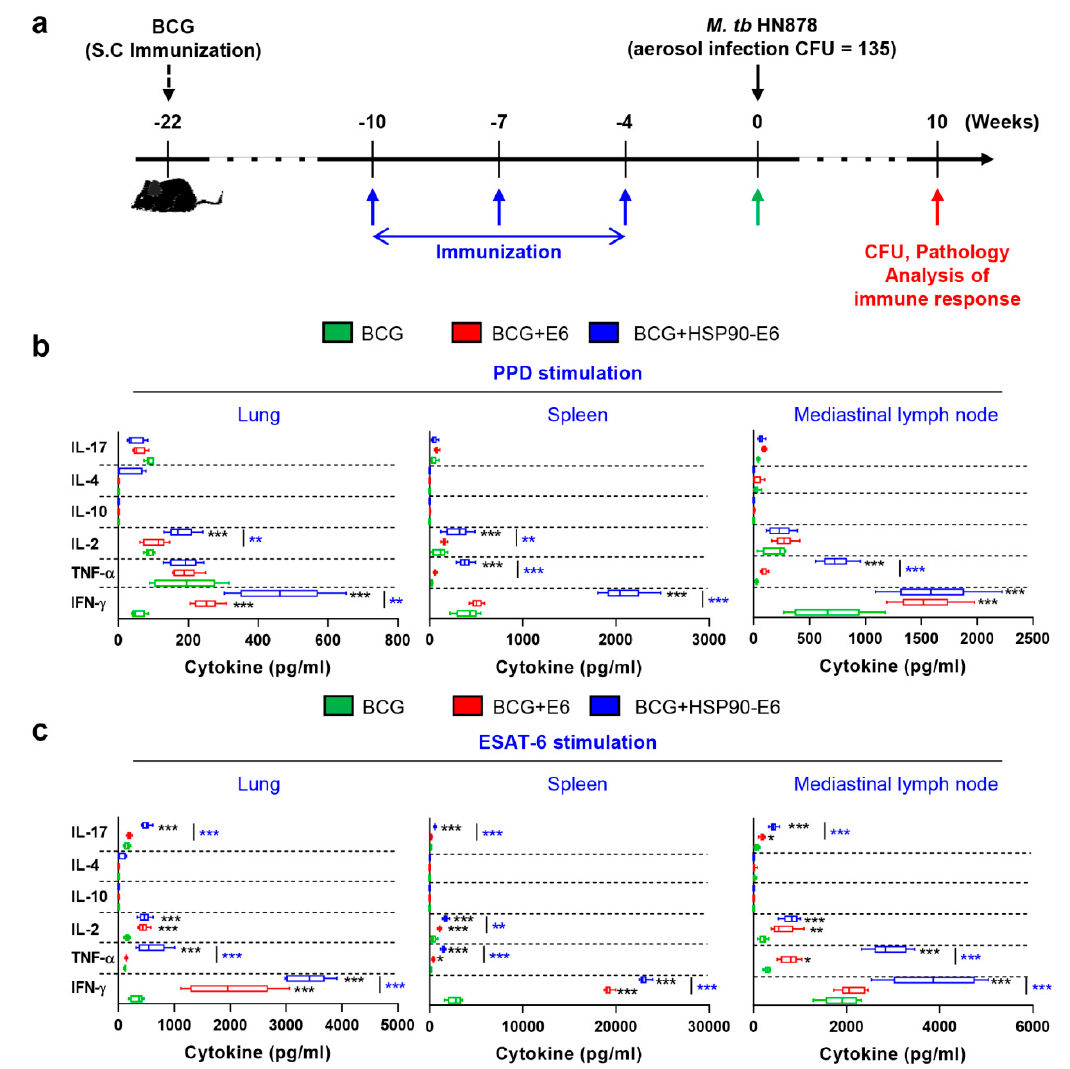
Figure 1. Comparative cytokine production profiles in Bacillus Calmette-Gu é rin (BCG)-, BCG + ESAT-6-, or BCG + HSP90-E6-vaccinated mice upon antigen (Ag) stimulation four weeks after final vaccination. ( a ) Experimental design for HSP90-E6 subunit vaccine testing. Mice (n = 12 per group) were immunised by BCG injection 12 weeks before subunit vaccination. Three intramuscular injection of HSP90-E6 / CIA05 were administered (blue arrows) before Mycobacterium tuberculosis (Mtb) HN878 aerosol challenge (black arrow). Immunological analysis was conducted before (green arrow) and after Mtb infection (red arrow). Bacterial counts and histopathology in each group were determined at the indicated time points after Mtb infection (red arrow). ( b , c ) Levels of IFN- γ , TNF- α , IL-2, IL-10, IL-4, and IL-17 secreted by lung, spleen, and lymph-node cells from each fully immunised group in response to ESAT-6 (2 µ g / mL) or purified protein derivative (PPD) (2 µ g / mL) stimulation as detected by enzyme-linked immunosorbent assay (ELISA). * p < 0.05, ** p < 0.01 and *** p < 0.001 compared to BCG-immunised mice. ** p < 0.01 and *** p < 0.001 between BCG + ESAT-6- and BCG + HSP90-E6-immunised mice.